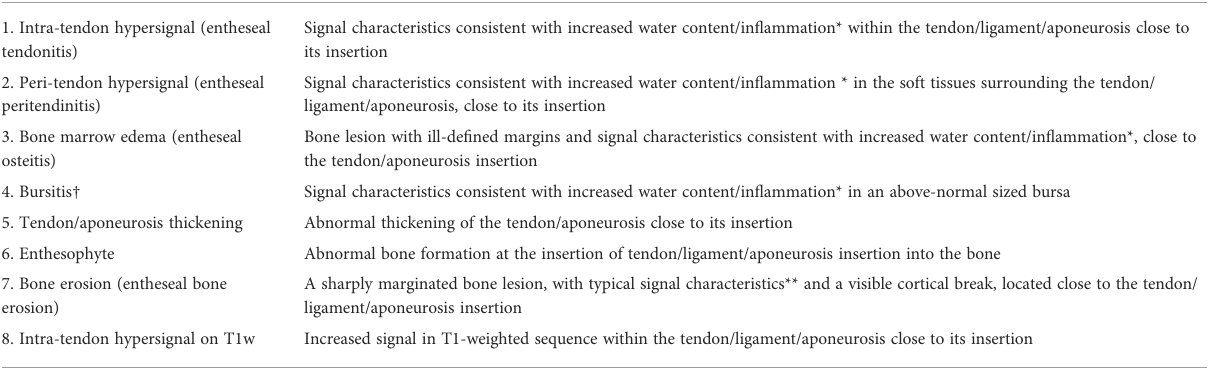
TABLE 6 Heel Enthesitis Scoring System (HEMRIS) (Ref. Mathew et al., J Rheumatol , 2019., 46(9): 1232 – 1238).